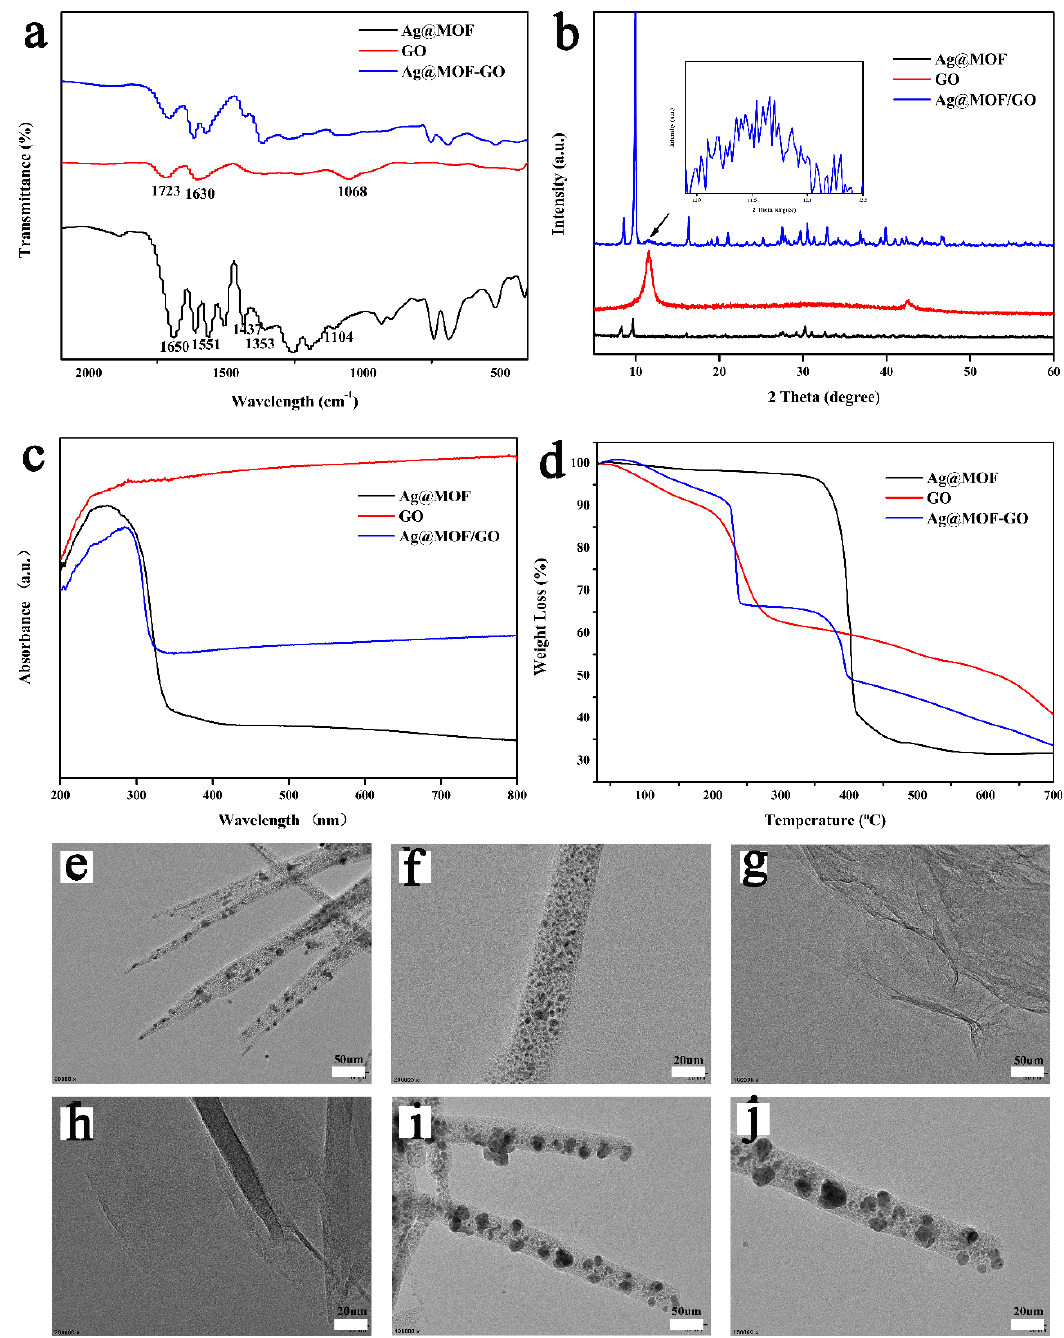
Figure 2. ( a ) FTIR spectrum, ( b ) XRD pattern, ( c ) UV–vis spectrum, ( d ) TGA curves of Ag@MOF, GO, and Ag@MOF–GO; TEM images of ( e , f ) Ag@MOF, ( g , h ) GO, and ( i , j ) Ag@MOF–GO. TEM images of ( e , f ) Ag@MOF, ( g , h ) GO, and ( i , j )